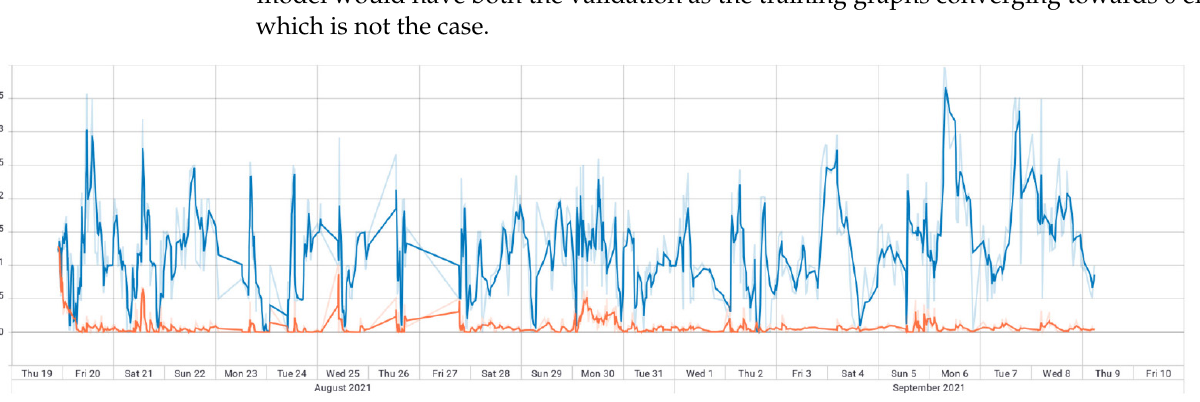
Figure 18. CNN ‐ LSTM with stock indicators loss (the orange line represents loss on training data and the blue line loss on validation data).